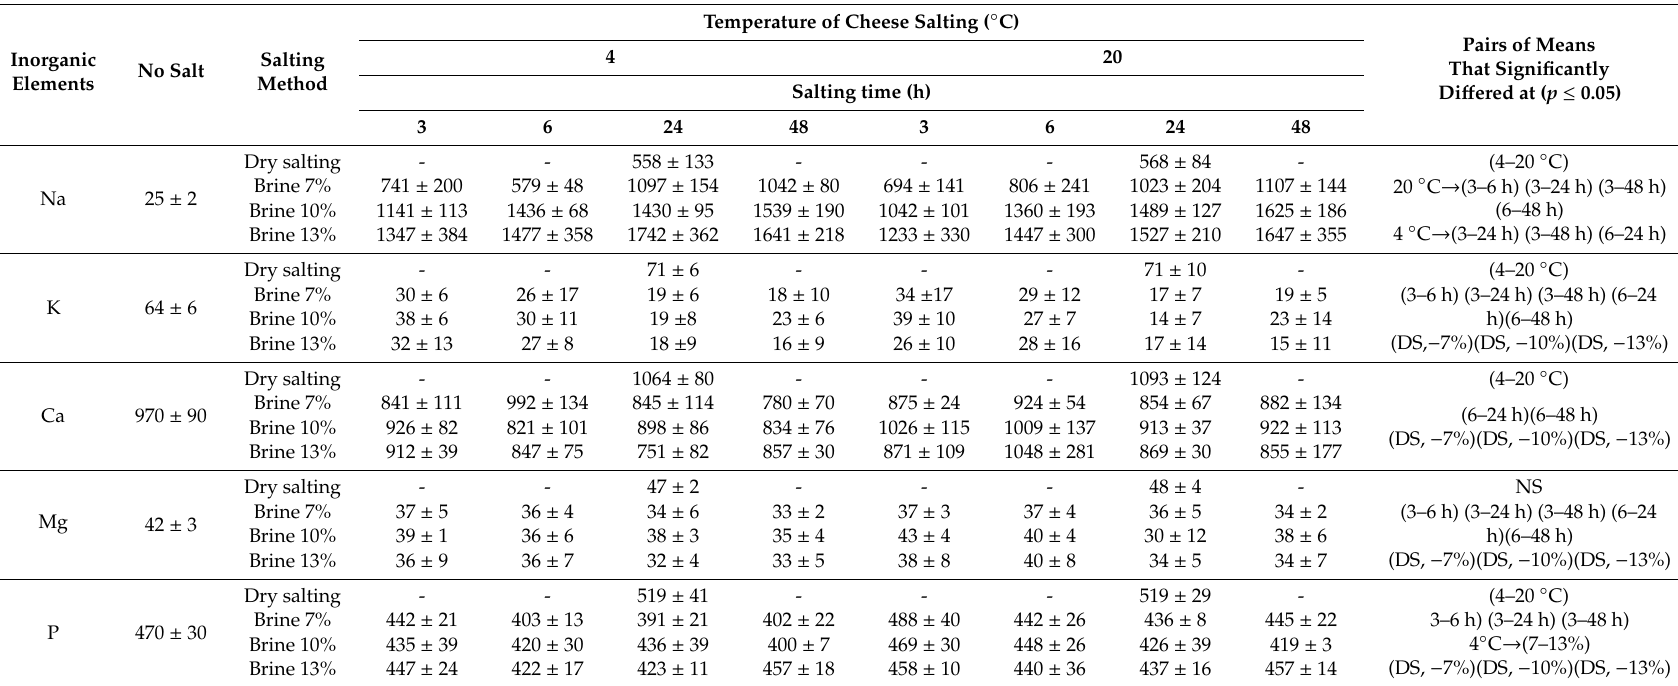
Table 2. Inorganic elements (mg / 100g) of Halloumi cheese salted by di ff erent methods at 4 and 20 ◦ C for di ff erent times (means of three trials ± SD).